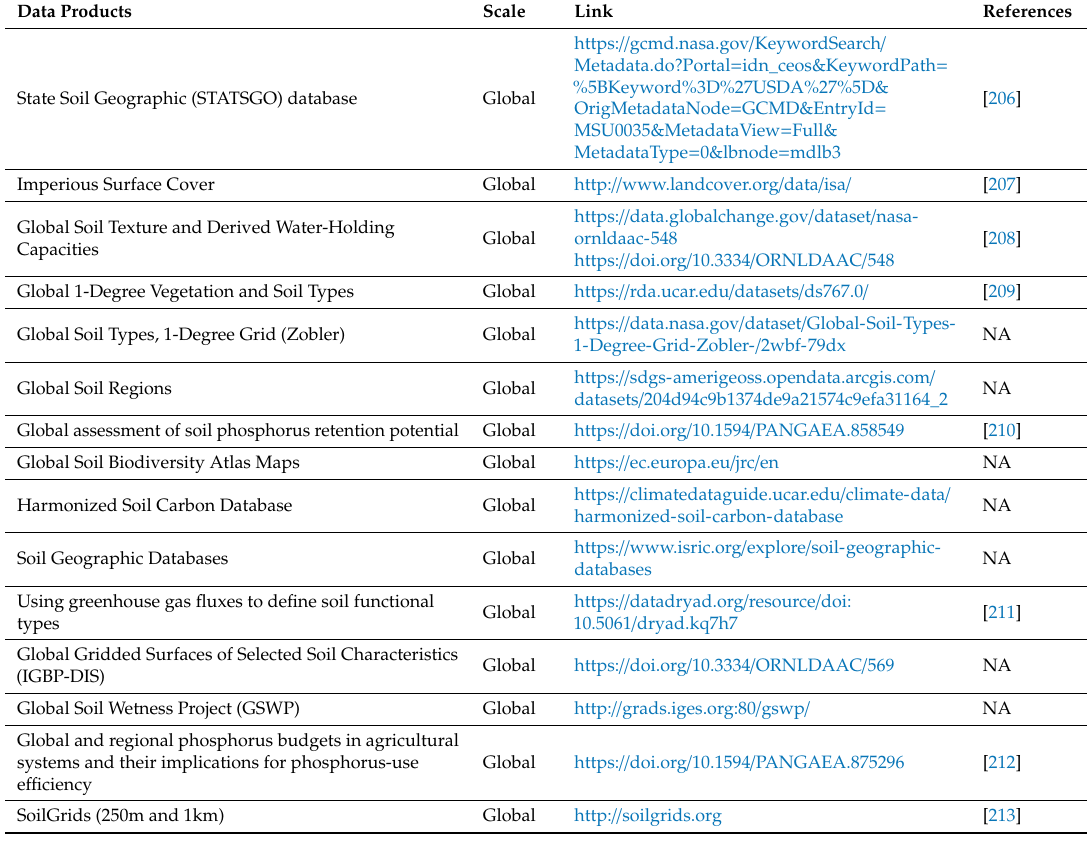
Table 4. Selection of RS-aided data products of soil